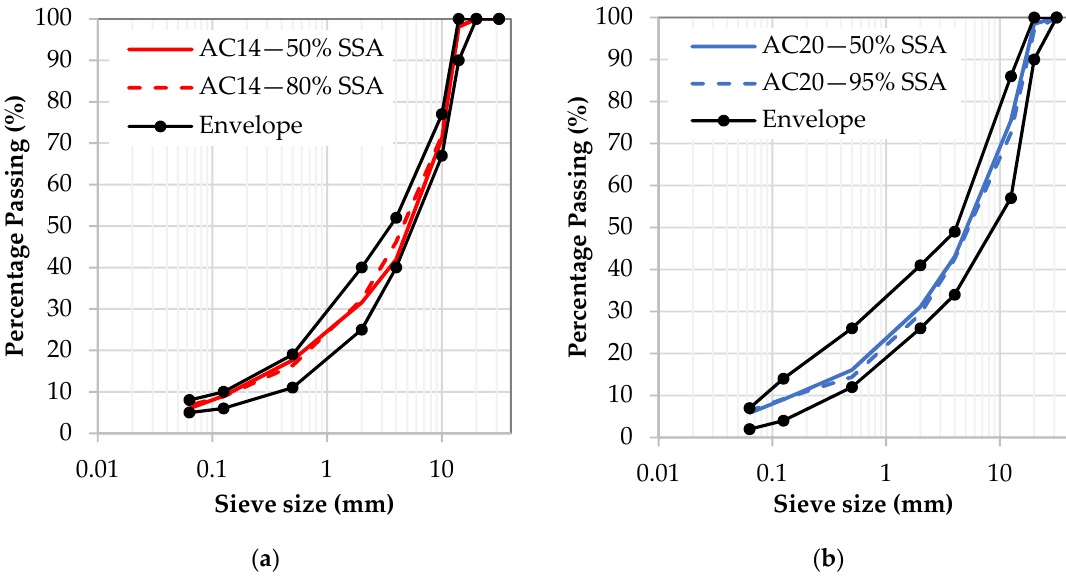
Figure 6. Grading curve adjustments for the asphalt mixtures with different SSA incorporation rates: ( a ) AC 14; ( b ) AC20. Table 4. Composition of the different asphalt mixtures evaluated in the preliminary